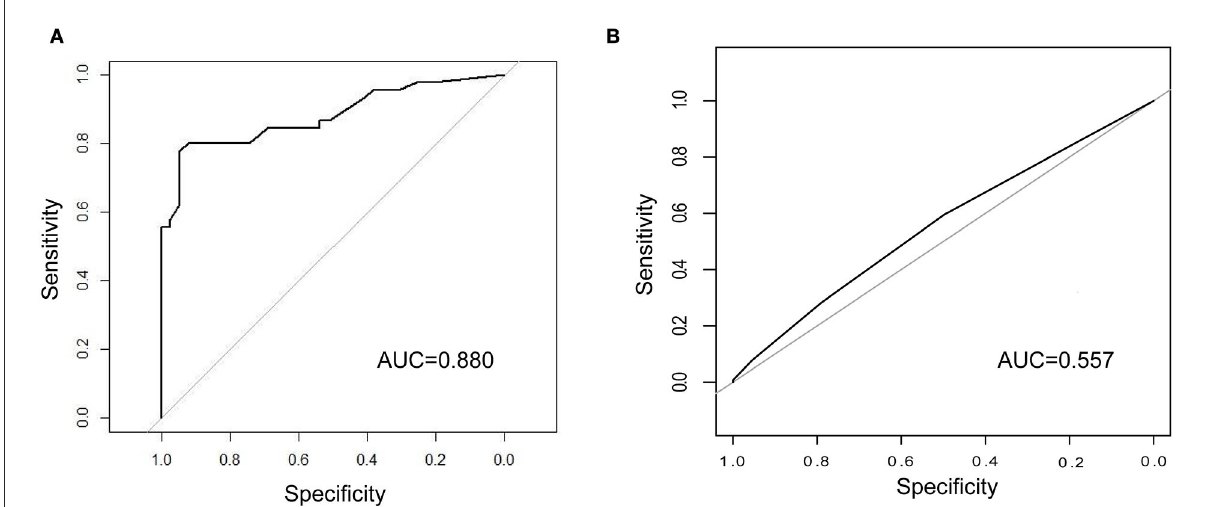
FIGURE6 Comparison of the predictive power between our tool and CURB-65 score. (A) ROC curve and AUC of predicting ICU admission in the external validation; (B) ROC curve and AUC of CURB-65 score for predicting ICU admission in our patients. ICU, intensive care unit; ROC, receiver operating characteristic; AUC, area under